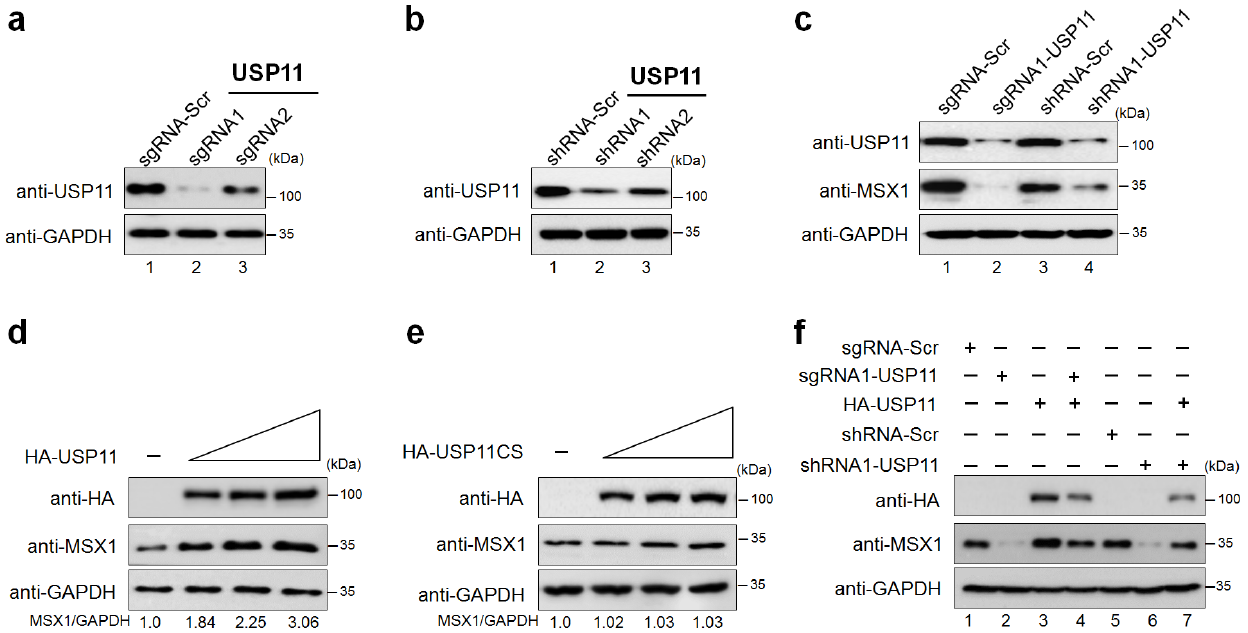
Figure 2. USP11 increases MSX1 protein level. ( a ) The efficiencies of sgRNA1 and sgRNA2 targeting the USP11 gene and regulating endogenous MSX1 protein levels were determined in hMSCs. ( b ) The efficiencies of shRNA1 and shRNA2 targeting the USP11 gene and regulating endogenous MSX1 protein levels were determined in hMSCs. ( c ) hMSCs were transfected with the best sgRNA (sgRNA1) and shRNA (shRNA1) targeting USP11 for the evaluation of endogenous USP11 and MSX1 levels using the respective endogenous antibodies. ( d ) hMSCs were transfected with an increasing amount of HA-USP11 (0, 1, 2, and 3 µ g), and the endogenous expression of MSX1 protein was analyzed using Western blot. The protein band intensities were estimated using ImageJ software with reference to the GAPDH control band (MSX1/GAPDH). ( e ) hMSCs were transfected with increasing amounts of catalytically inactive HA-USP11CS (0, 1, 2, and 3 µ g), and the endogenous expression of MSX1 protein was analyzed using Western blot. The protein band intensities were estimated using ImageJ software with reference to the GAPDH control band (MSX1/GAPDH). ( f ) Reconstitution effect of USP11 on endogenous MSX1 in USP11-depleted cells. Protein expression was analyzed by Western blotting using the indicated antibodies. GAPDH was used as the loading